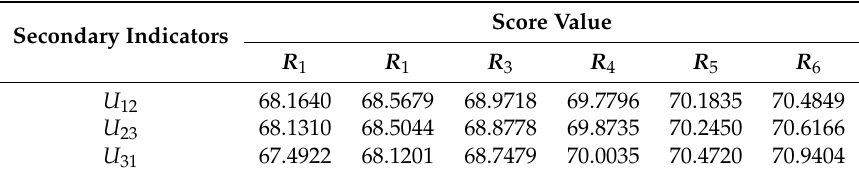
Table 11. The score value of each scheme (Project